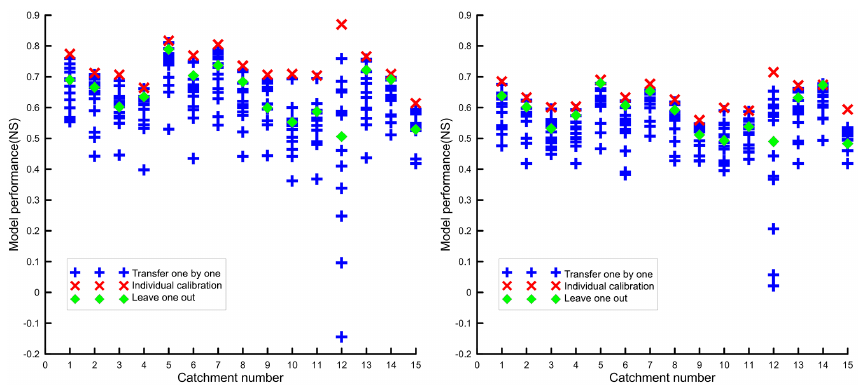
Figure 6. Mean NS model performance of the calibration, individual parameter transfer, and for the leave-one-out transfer for the selected 15 catchments for the calibration time period 1971–1980. Left panel: HBV, right panel: HYMOD.